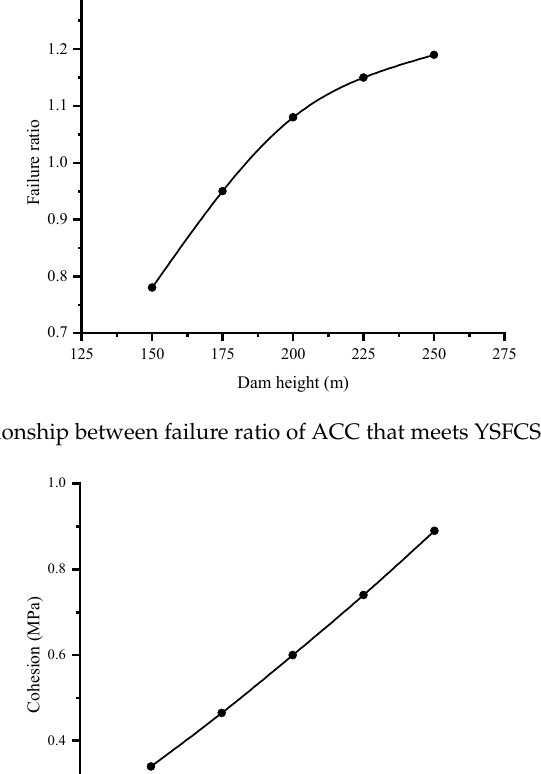
Figure 14. Relationship between internal friction angle of ACC that meets YSFCS and dam height . 2.4.3. Value Ranges of the Strength Parameters of UACC That Comprehensively Meet YSFCS The value ranges of the strength parameters (failure ratio R f , cohesion C , and internal friction angle φ ) of ACC that comprehensively meet the YSFCS are back-calculated. It is assumed that other